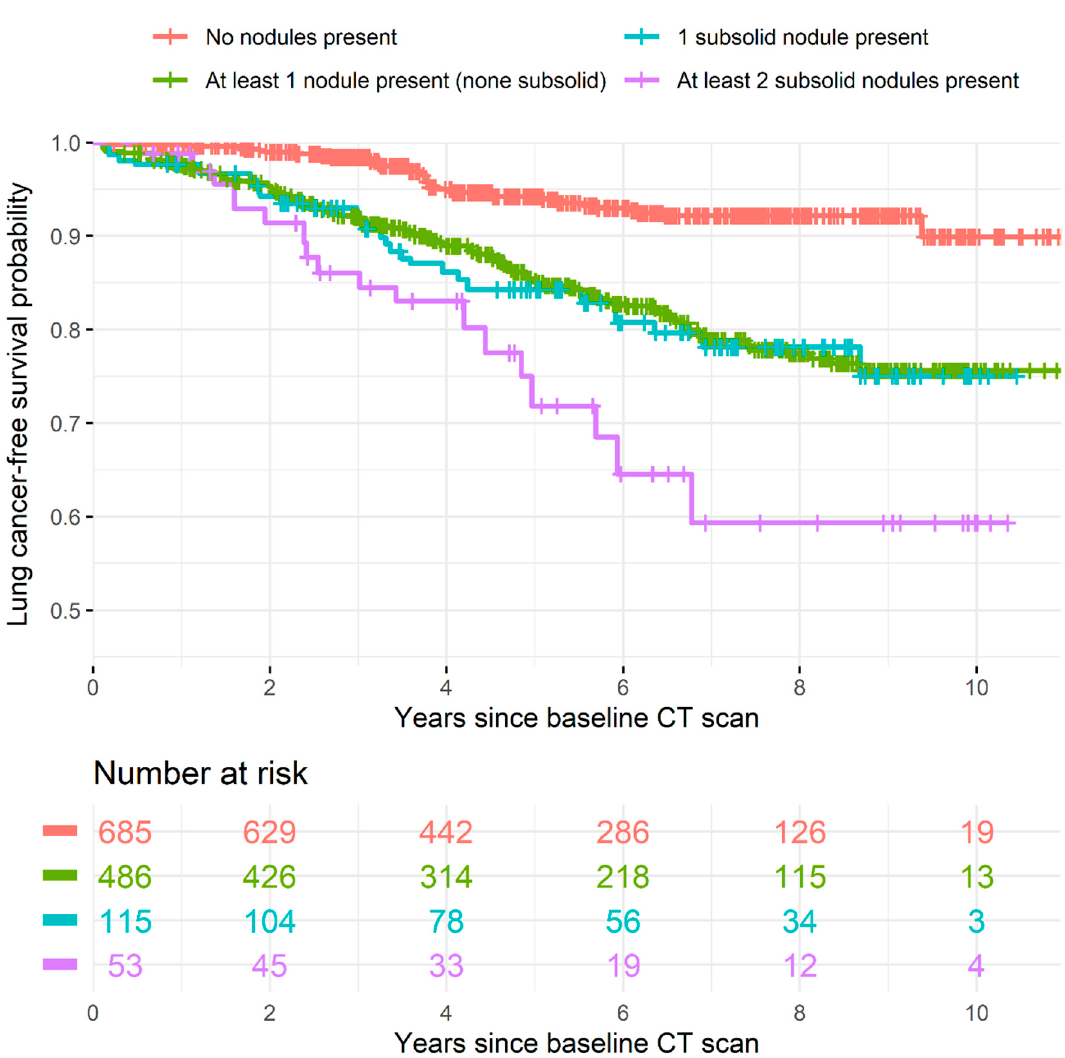
Figure 3. Lung cancer probability by nodule types present at baseline. This figure shows a Kaplan–Meier curve of lung- cancer-free survival, including a “number at risk” table. Vertical dashes on a line indicate the end of patients’ follow-up. The 5-year lung-cancer-free weighted survival probabilities were 0.942 (95% confidence intervals = 0.916, 0.969) when no nodules were present at baseline, 0.852 (0.817 to 0.887) when only solid nodules were present, 0.843 (0.775 to 0.917) when one SSN was present, and 0.718 (0.594 to 0.868) when at least two SSNs were present. The same figure with confidence intervals is provided as Figure S1.